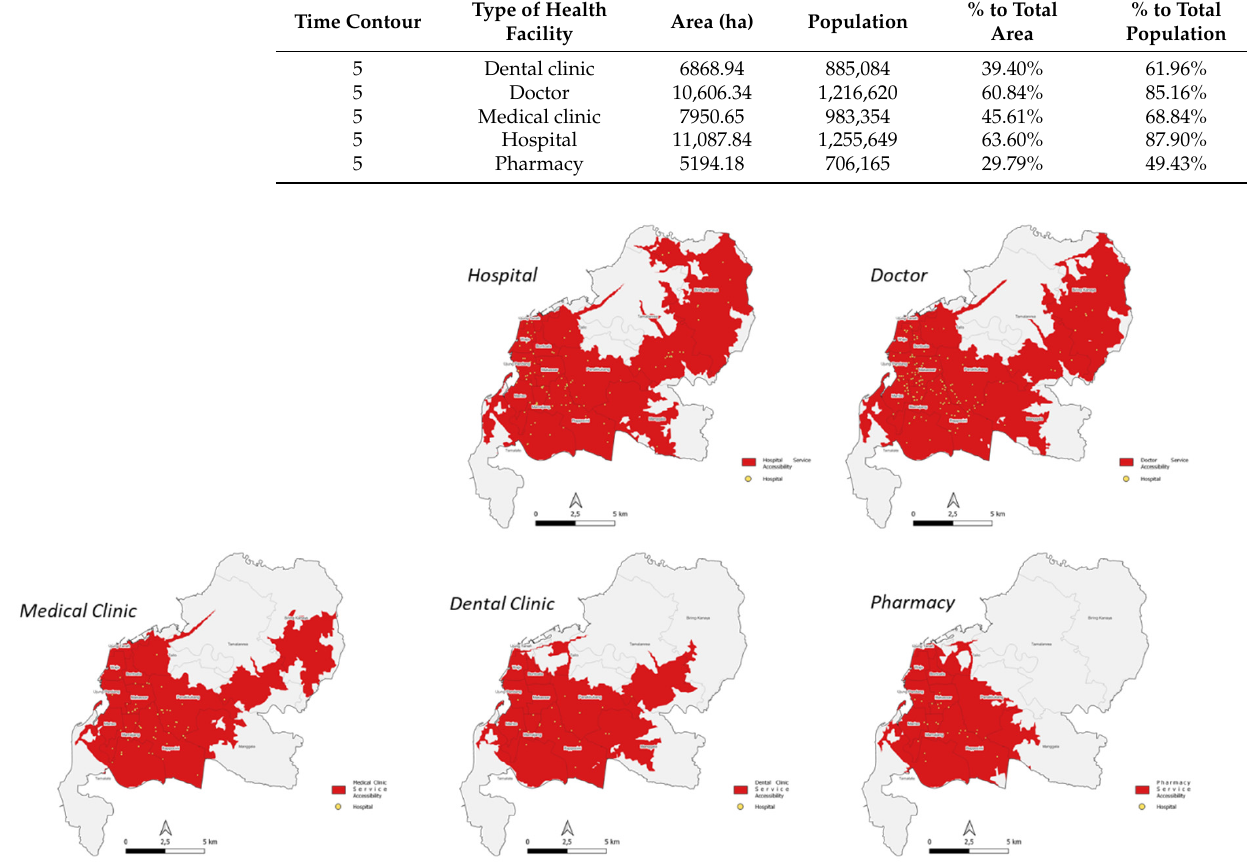
Figure 5. Health Facility Outreach Map According to a Time Contour of 5 Minutes.